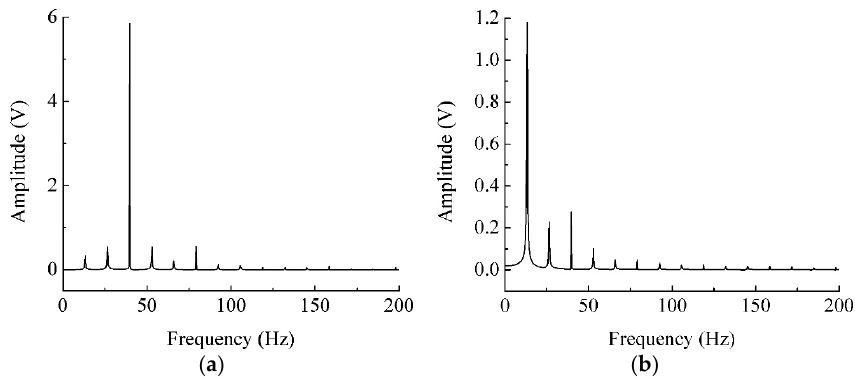
Figure 8. Fast Fourier transform (FFT) of open-circuit voltage. ( a ) V 1 ; ( b ) V 2 .